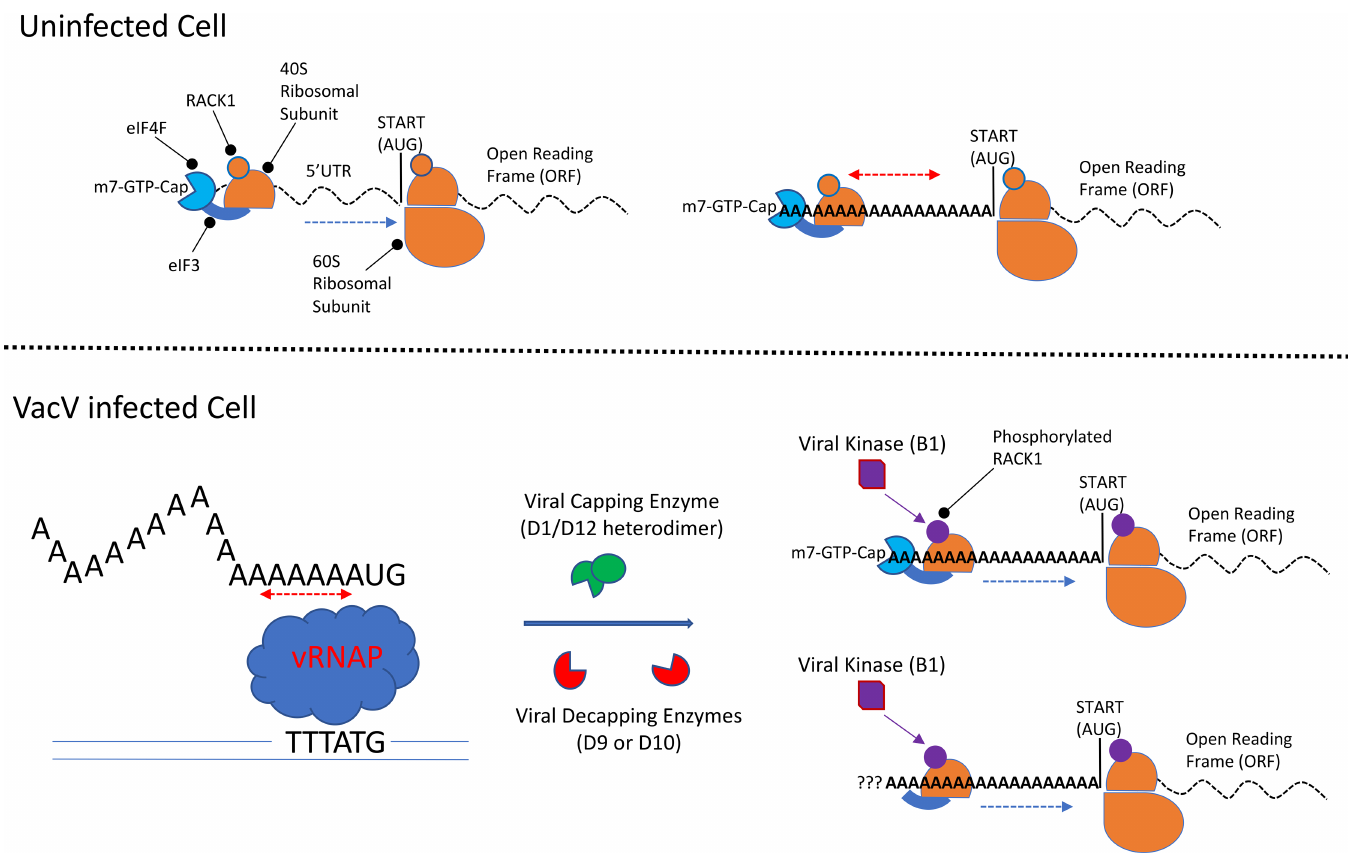
Fig 1. In uninfected cells (top), the 40S ribosomal subunit is recruited to the mRNA m-7-GTP cap through the combined actions of eIF4F and eIF3. The ribosomethen scans (blue arrow) the 5 0 UTR in search of a start codon, at which point the 60S ribosomal subunit joins to initiate translation.Ribosomes slide (red arrows) on polyA stretches, and 5 0 polyA leaders do not act as enhancersin mammalian cells. In VacV-infectedcells (bottom), the vRNAP slips on intermediate and late promoters, reiteratingadenosineresidues to create randomly sized polyA leaders. Viral enzymes control mRNA cappingand decapping in infected cells, where polyA leaders enableeither cap-dependent or cap-independenttranslationof viral mRNAs; whether cap-independenttranslation occurs on viral mRNAs that have been decapped or were never cappedremains unknown (?). Modification of RACK1 by the viral B1 kinase contributes to the ability of polyA leaders to function in infected cells. eIF, eukaryoticinitiationfactor; m-7-GTP, 7-Methylguanosine-5’-triphosphate; RACK1, receptorfor activated C kinase 1; UTR, untranslated region; VacV, vacciniavirus; vRNAP, viral RNA polymerase.